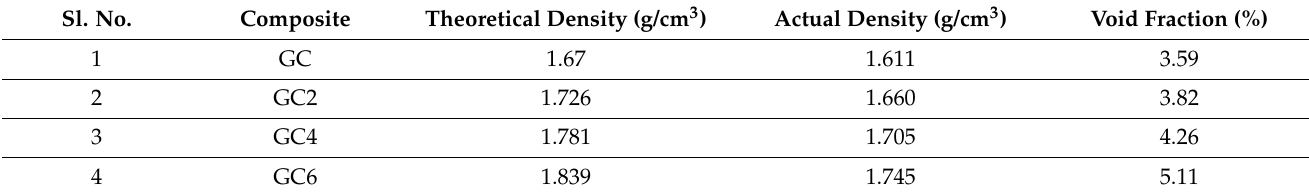
Table 3. Theoretical and measured densities along with void fractions in composites. Sl. No.